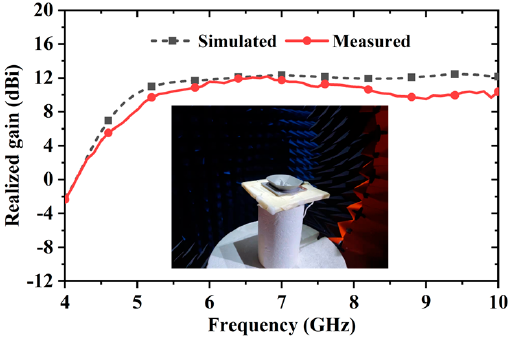
Figure 16. Simulated and measured radiation patterns of the proposed antenna at different frequen- cies on the E-plane.